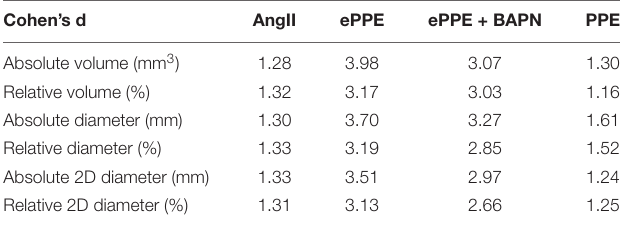
TABLE 2 | Standardized effect size for paired samples t -test based on Cohen’s calculation, comparing baseline to first time point of AAA measurement of absolute or relative volume and maximum aortic diameter in 3D US analysis as well as conventional 2D B-mode diameter assessment in all four mouse models.